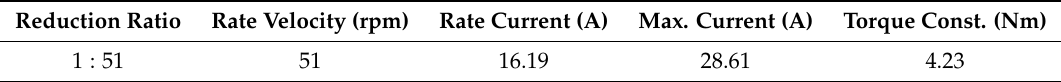
Table 1. Parameters of used motor